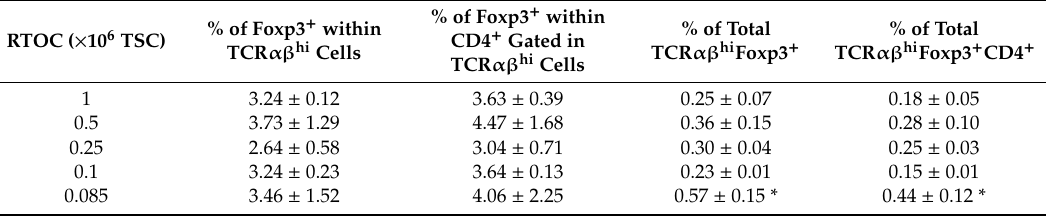
Table 4. Proportions of T regulatory cells